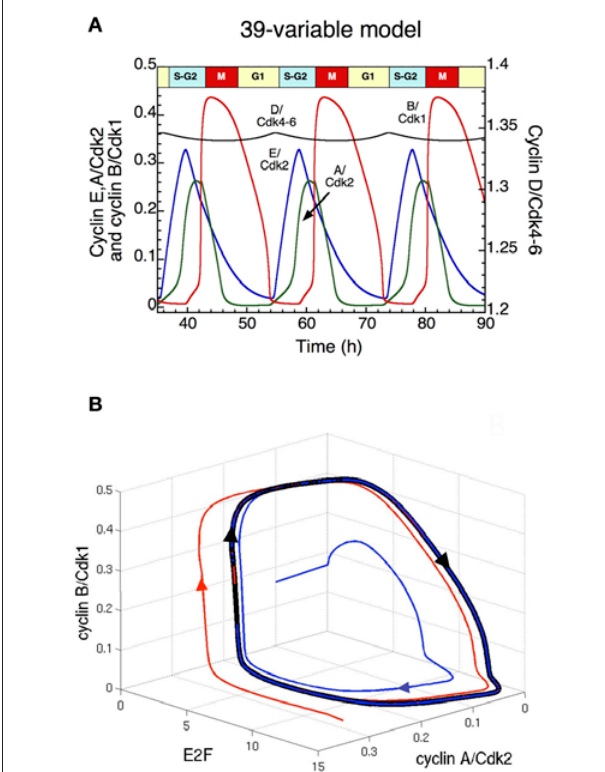
FIGURE 2 | Sustained oscillations of the Cdk network in the detailed model for the mammalian cell cycle (Gérard and Goldbeter, 2009). (A) The time evolution of cyclin D/Cdk4–6 (in black), cyclin E/Cdk2 (in blue), cyclin A/Cdk2 (in green) and cyclin B/Cdk1 (in red) is shown in the presence of a suprathreshold level of growth factor. In the concentration space, these sustained oscillations correspond to the evolution toward a limit cycle. Cyclin D/Cdk4–6 is the total active form of the kinases, which is composed of cyclin D/Cdk4–6 and also the complex formed by cyclin D/Cdk4–6 and p21/p27 (see Gérard and Goldbeter, 2009 for more details). (B) Projection of the limit cycle (closed black curve) in the E2F—cyclin A/Cdk2—cyclin B/Cdk1 space. By starting from two different initial conditions (blue and red curves), the Cdk network tends to the limit cycle attractor projected in this three-dimensional space. Parameter values are as in Table S2 in Gérard and Goldbeter (2009).